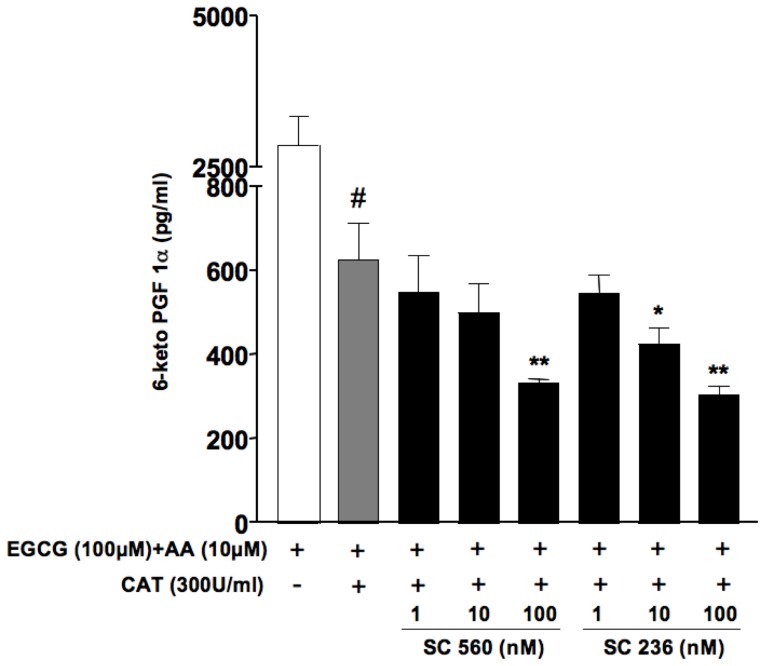
Effect of treatment with selective COX-1 (SC560) or COX-2 (SC236) inhibitors toward PGI2 production in HUVECs incubated with EGCG, in the presence of catalase.Cells were incubated in medium 5% FCS in the presence of increasing concentrations of SC560 or SC236 (1–100 nM); 10 min after treatment with inhibitors, cells were treated with catalase (300 U/ml) for 15 min. Afterward, arachidonic acid (10 µM) and EGCG (100 µM) were added for 30 min. PGI2 was evaluated as 6-keto-PGF1α in aliquots of cell supernatants using a specific EIA. Values are expressed as pg/ml ± SE (n = 3) of the 6-keto-PGF1α. #P<0.01 vs (EGCG+AA); *P<0.05 and **P<0.01 vs. (EGCG+AA+catalase).